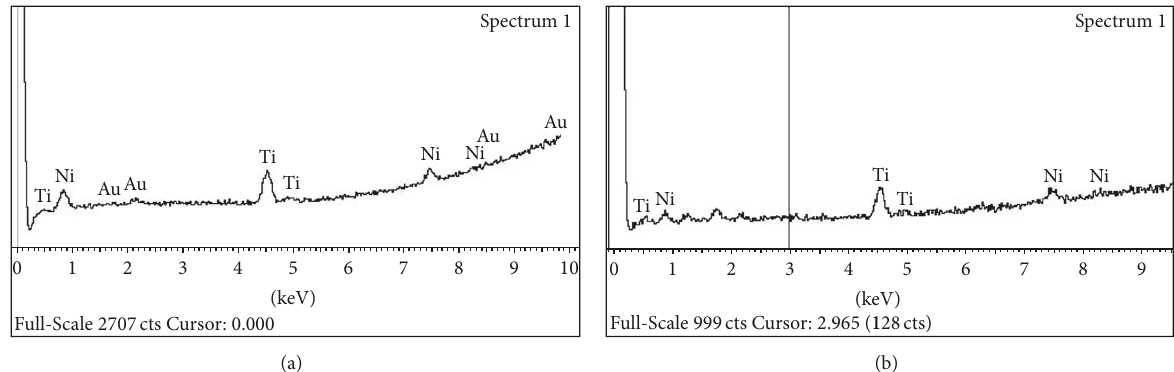
Figure 3: EDS analysis of as-received K3 instrument (a) and HF-treated K3 instrument (b). As-received and HF-treated K3 instruments showed no difference in ion composition.